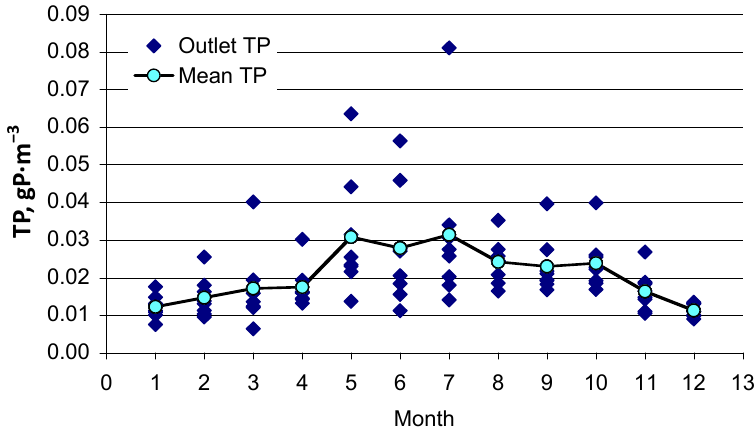
Figure 15. Variability of outlet TP concentrations at Boney Marsh. The mean TP values are means for the designated month. (Source: unpublished data from South Florida Water Management District (SFWMD)).